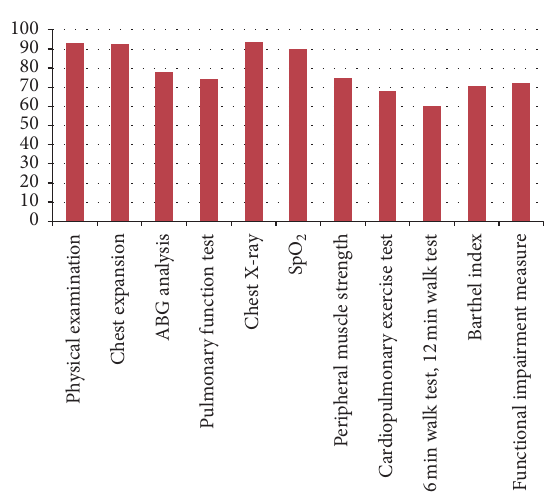
Figure 2: Preoperative assessment for thoracic surgery